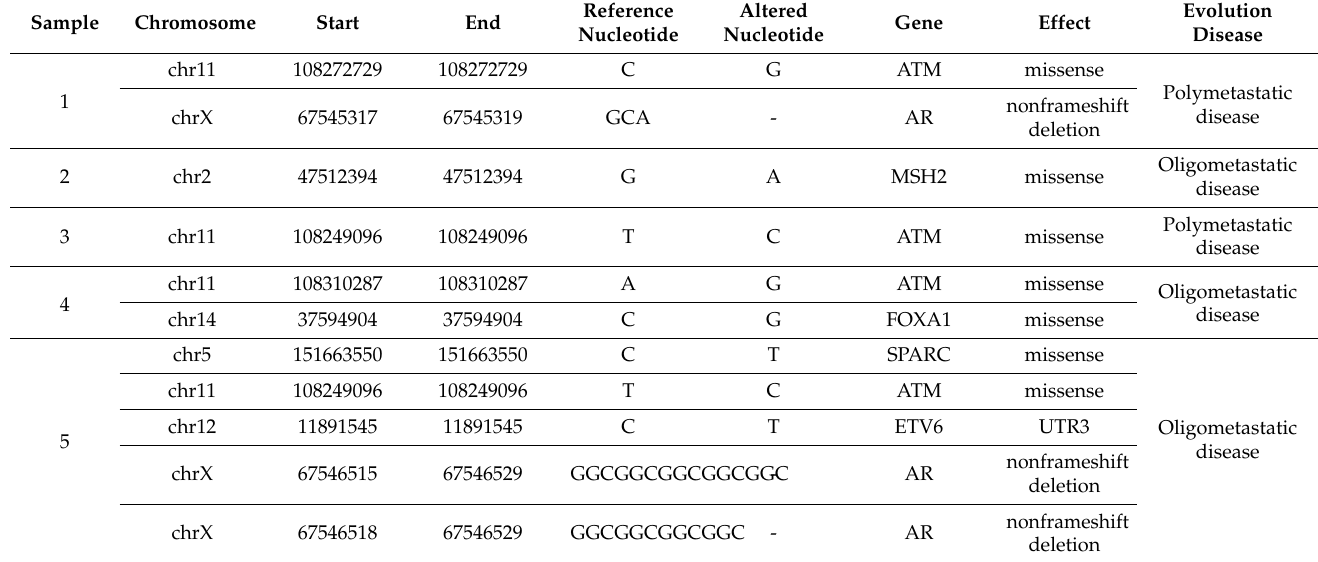
Table A2. List of the 77 detected mutations from the DNA sequencing of 37 prostate cancer-relevant genes (nucleotide